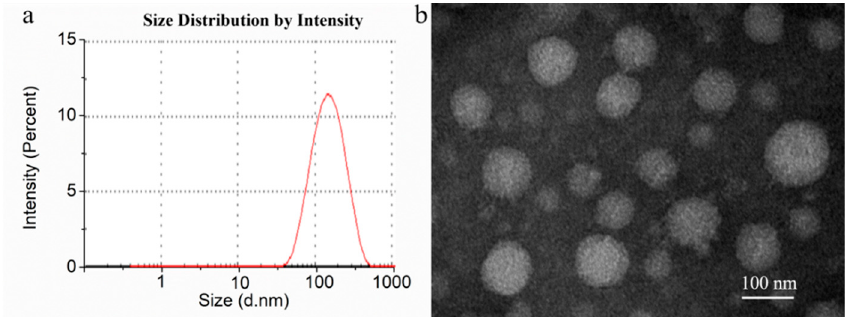
Figure 3. Size distribution ( a ) and transmission electron microscope image ( b ) of docetaxel (DTX)- loaded BSPs-SA 12.94 nanoparticles. The transmission electron microscope image is shown with a magnitude 80,000× and scale of 100